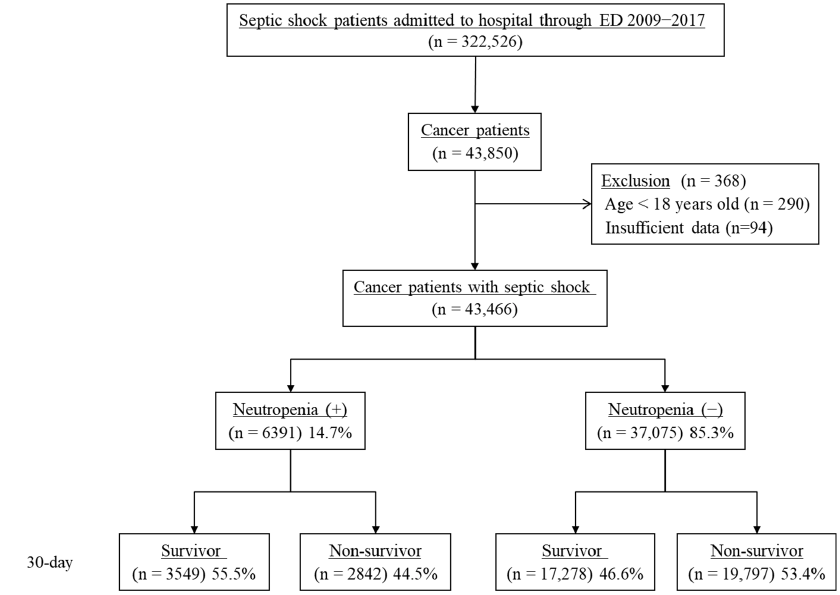
Figure 1. Patient flow diagram. ED, emergency department.